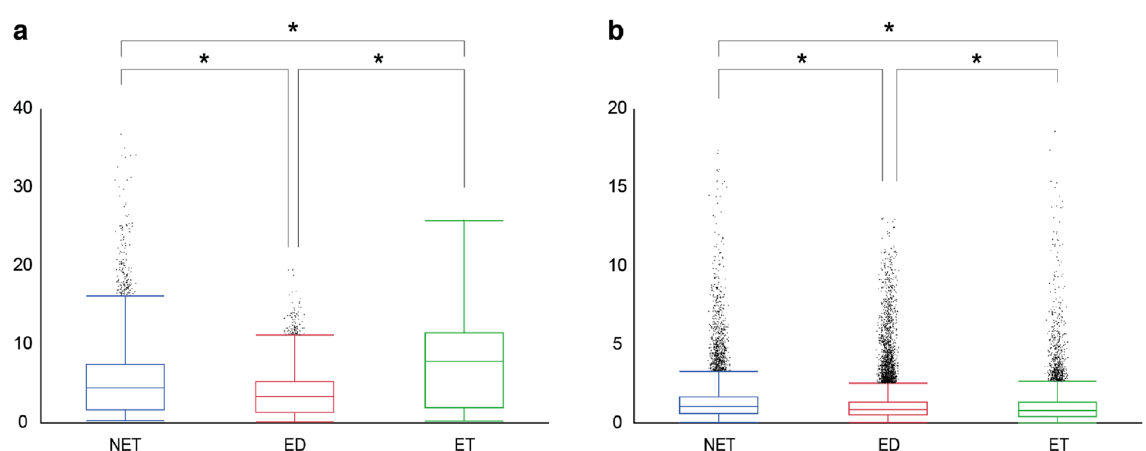
Figure 7. Quantitative evaluation of overlap between responsible regions and segmentation labels. ( a ) Difference values of HGG responsible regions in each segmentation label: Gd-enhanced tumor (ET), peritumoral edema (ED), and necrotic and non-enhancing tumor core (NET). The values in the ET region are the highest among the three segmentation categories. ( b ) Difference values of LGG responsible regions for the same segmentation labels. The NET regions have the highest values; * indicates a statistical significance < 0.0001